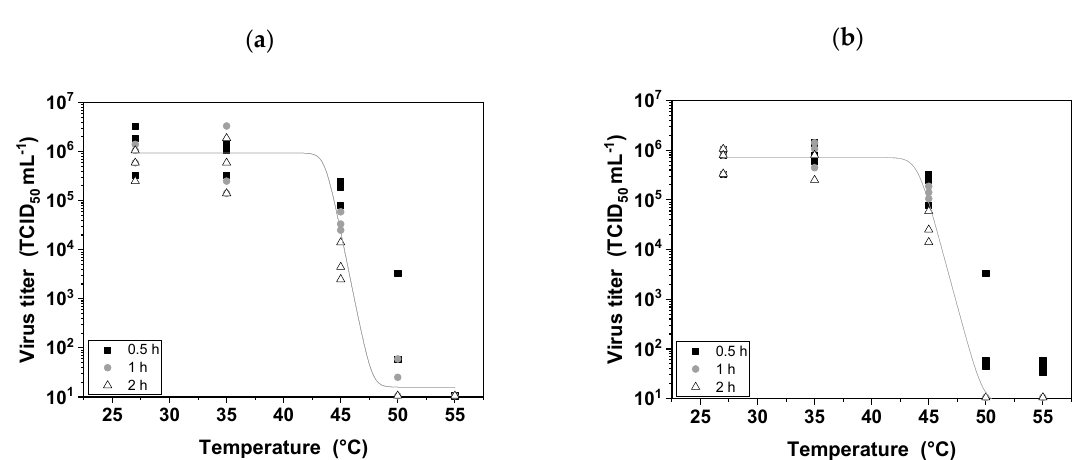
Figure 2. Short-term thermostability of MV. Suspensions of MV in serum-containing medium ( a ) or serum-free medium ( b ) were incubated for 30 min, 1 h, and 2 h at temperatures between 27 and 60 °C. Experiments were conducted in triplicate, and all data points are shown.